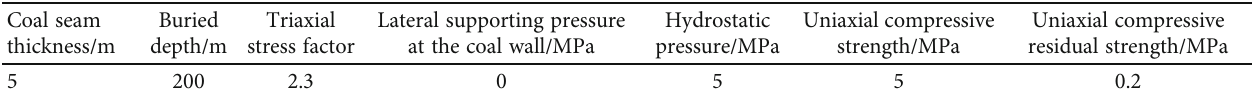
Figure 7: Distribution characteristics of abutment pressure in working face. Table 2: Wilson ’ s theoretical formula